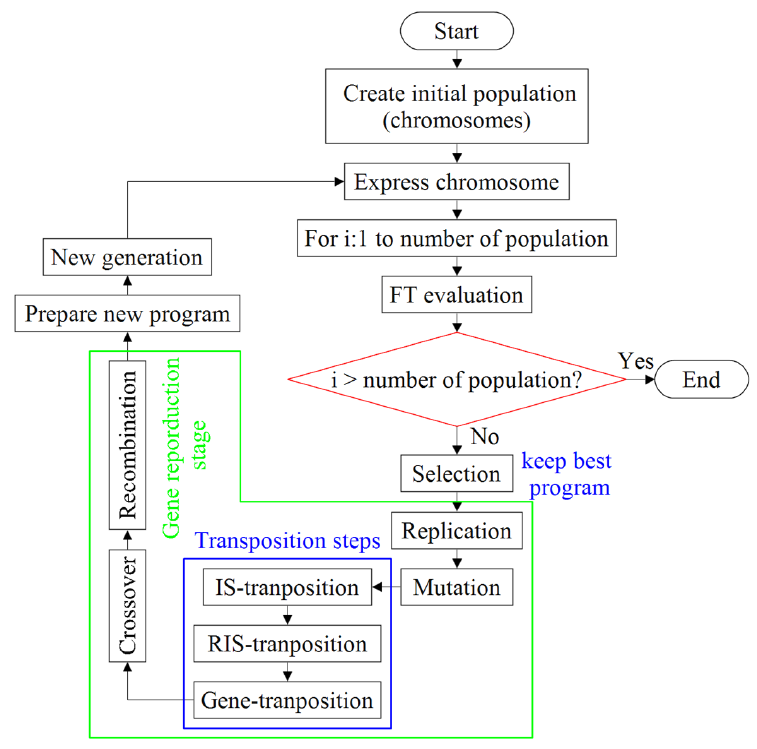
Figure 3. Flow diagram of GEP algorithm.